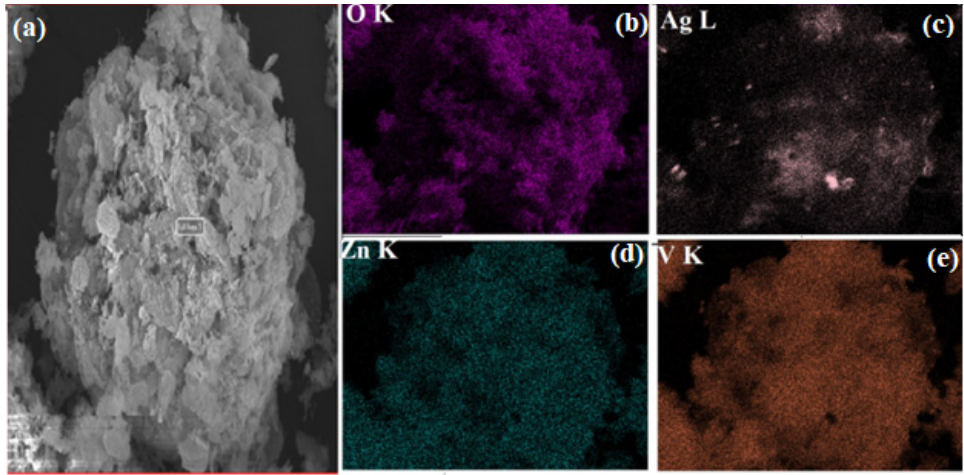
Figure 4. Selected-area SEM image ( a ) and mapping images of O ( b ), Ag ( c ), Zn ( d ), and V ( e ) elements present in ZnV@Ag NC.